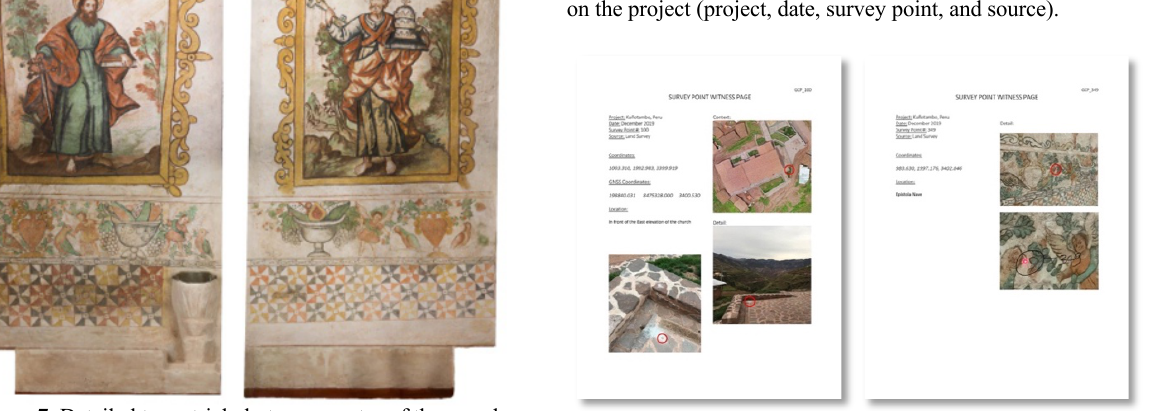
Figure 9-10 . Witness Sheets ( fixed GCP 100 / natural GCP 349 ) . Image s by CIMS © GCI